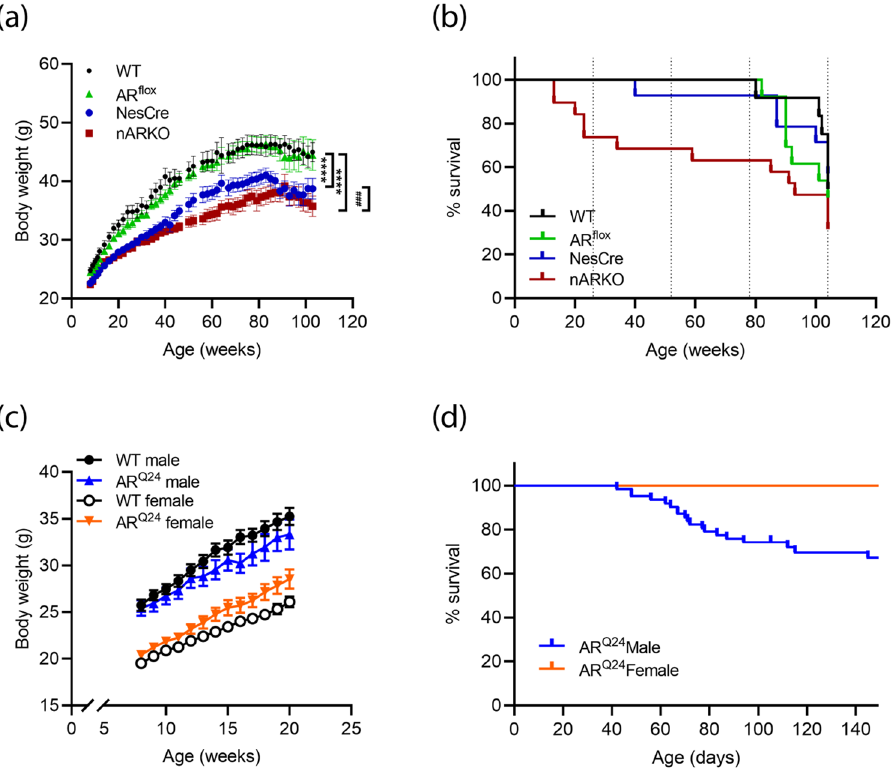
Figure 2. Impact of neural AR deletion and global AR overexpression on male mouse survival. (a) Body weight analysis of AR flox x NesCre cross mice over 24 months. Mean ± SEM, n = 11–13 mice per group. **** P < 0.0001 vs WT; ### P < 0.001 vs NesCre by mixed-effects analysis with Tukey’s multiple comparison test for main genotype effect. (b) Kaplan–Meier curves of AR flox x NesCre cross mouse survival over 24 months; n = 12 WT; n = 13 AR flox ; n = 14 NesCre; n = 10 nARKO. (c) Body weight analysis of WT and AR Q24 mice to P150. Mean ± SEM, n = 12–14 mice per group. (d) Kaplan–Meier curves of AR Q24 transgenic mouse survival over 150 days; n = 62